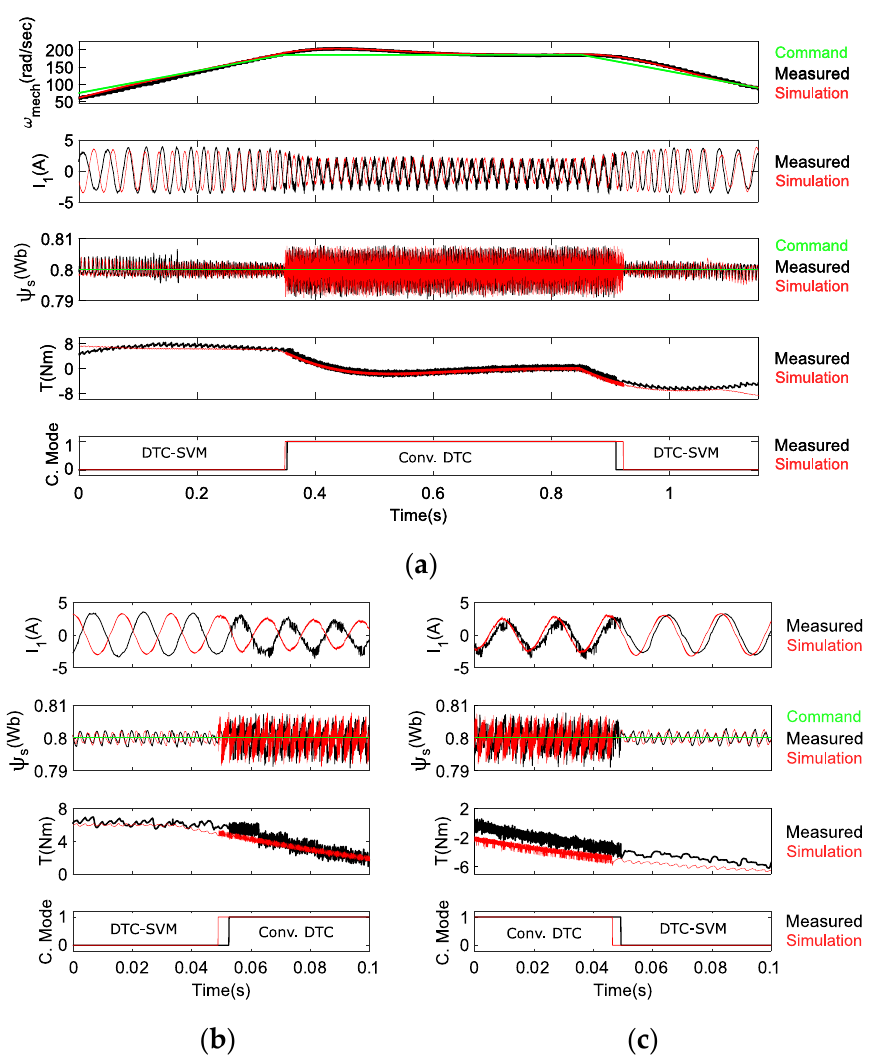
Figure 20. Transition between control modes for no-load condition: ( a ) whole operation region, ( b ) transition from DTC – SVM to conventional DTC and ( c ) transition from conventional DTC to DTC – SVM.